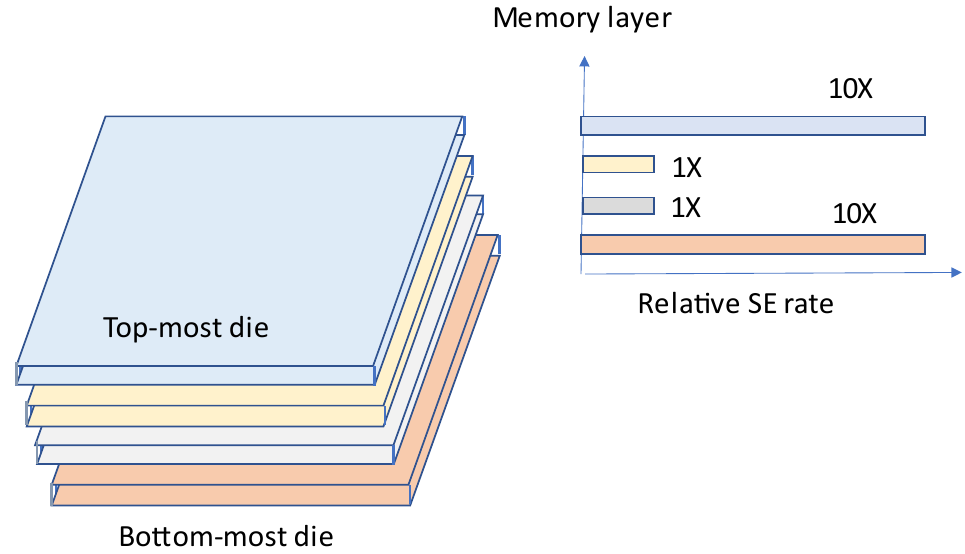
Figure 13. SER of different layers in a 3D DRAM integration [10].